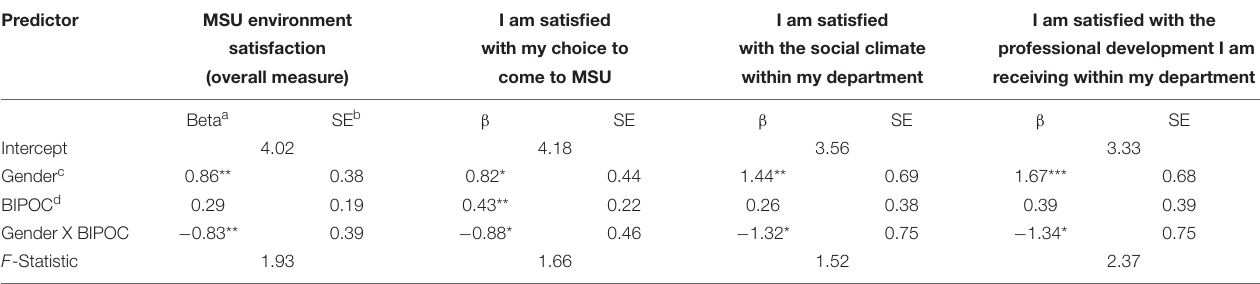
TABLE 8 | Gender interacting with BIPOC to predict MSU environment satisfaction questions. Predictor